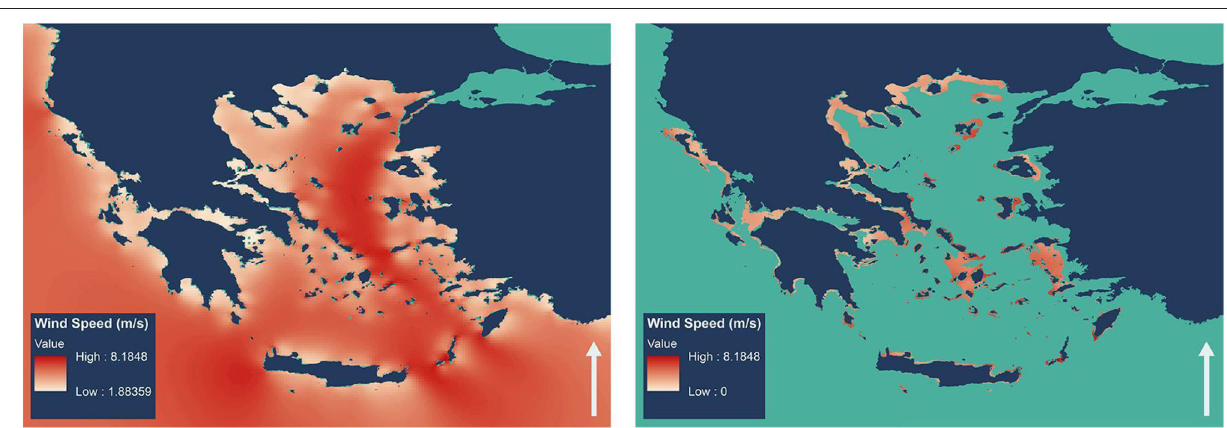
FIGURE 4 | BE plants not implemented (Greece) (http://gismarblack.bo.ismar.cnr.it:8080/mokaApp/apps/COCOV3H5/index.html?null).